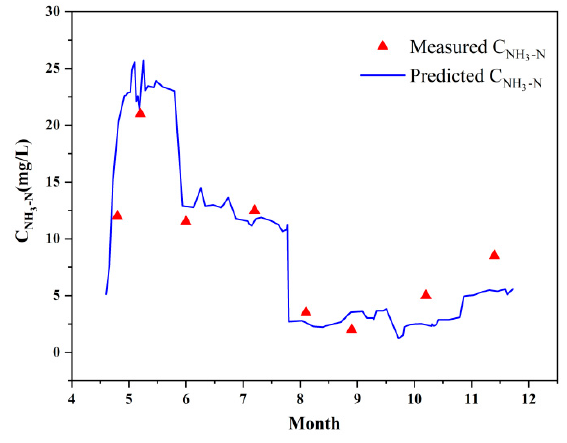
Figure 6. Simulated results of the NH 3 -N concentration in